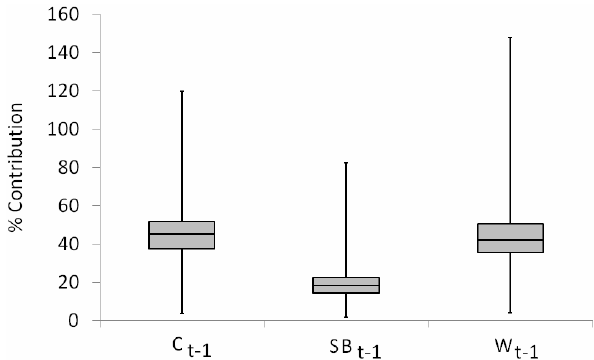
Figure 9. Proportional contributions of lagged upstream inputs to discharge forecast at Fig. 9. Proportional contributions of lagged upstream inputs to dis- Skelton. charge forecast at Skelton.